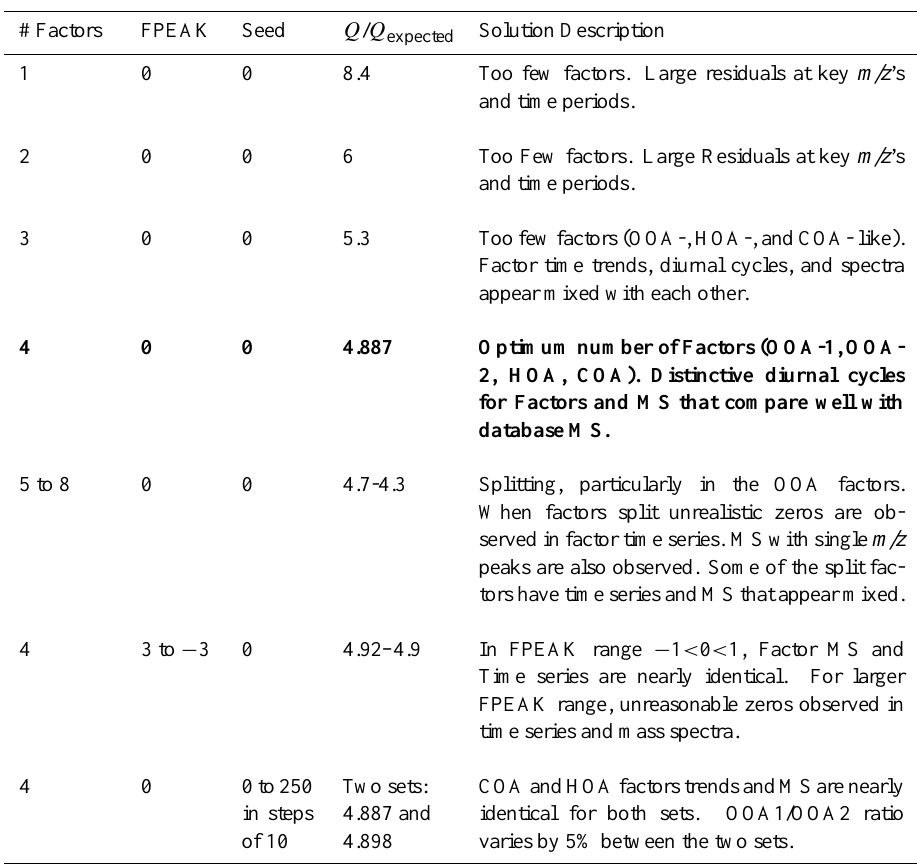
Table 1. Description of PMF Solutions obtained for this dataset.